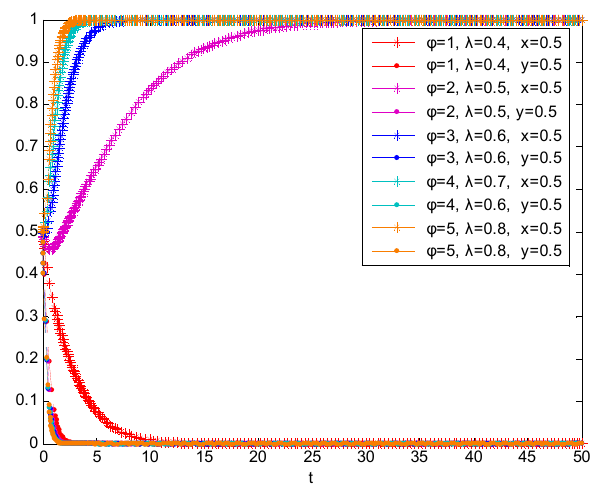
Figure 8. Simulation results of the evolutionary game between the two parties under the condition that corruption of government and awareness of people is improved.